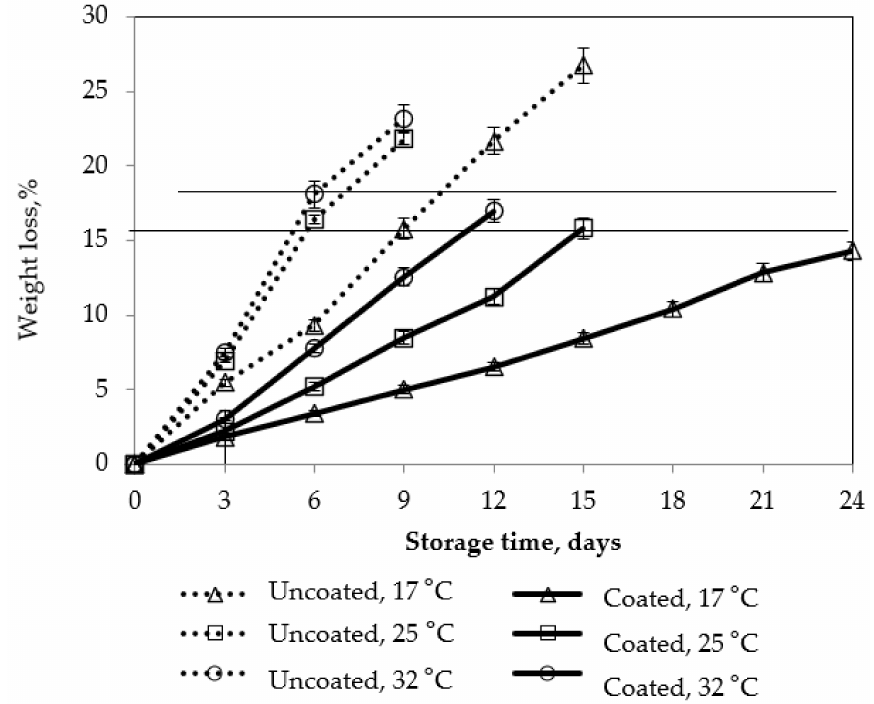
Figure 7. Effect of storage temperature on weight loss of mango fruits. Numbers are the mean ± standard errors of three